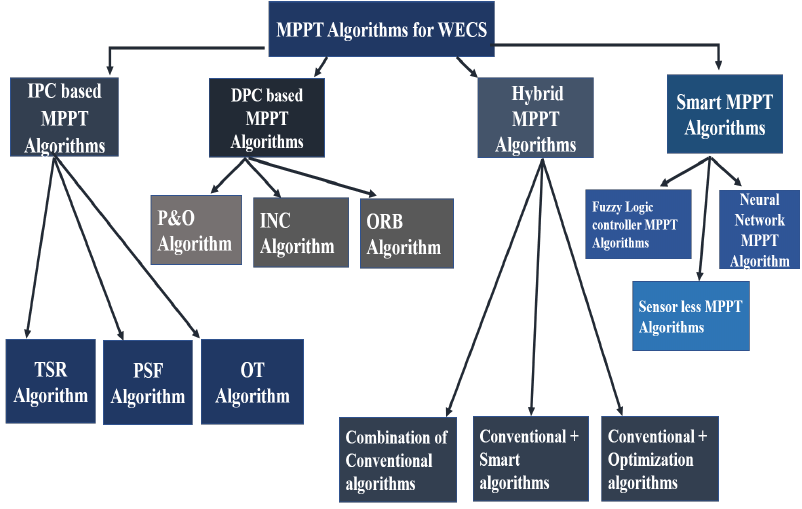
Figure 6. Classification of MPPT Algorithms for